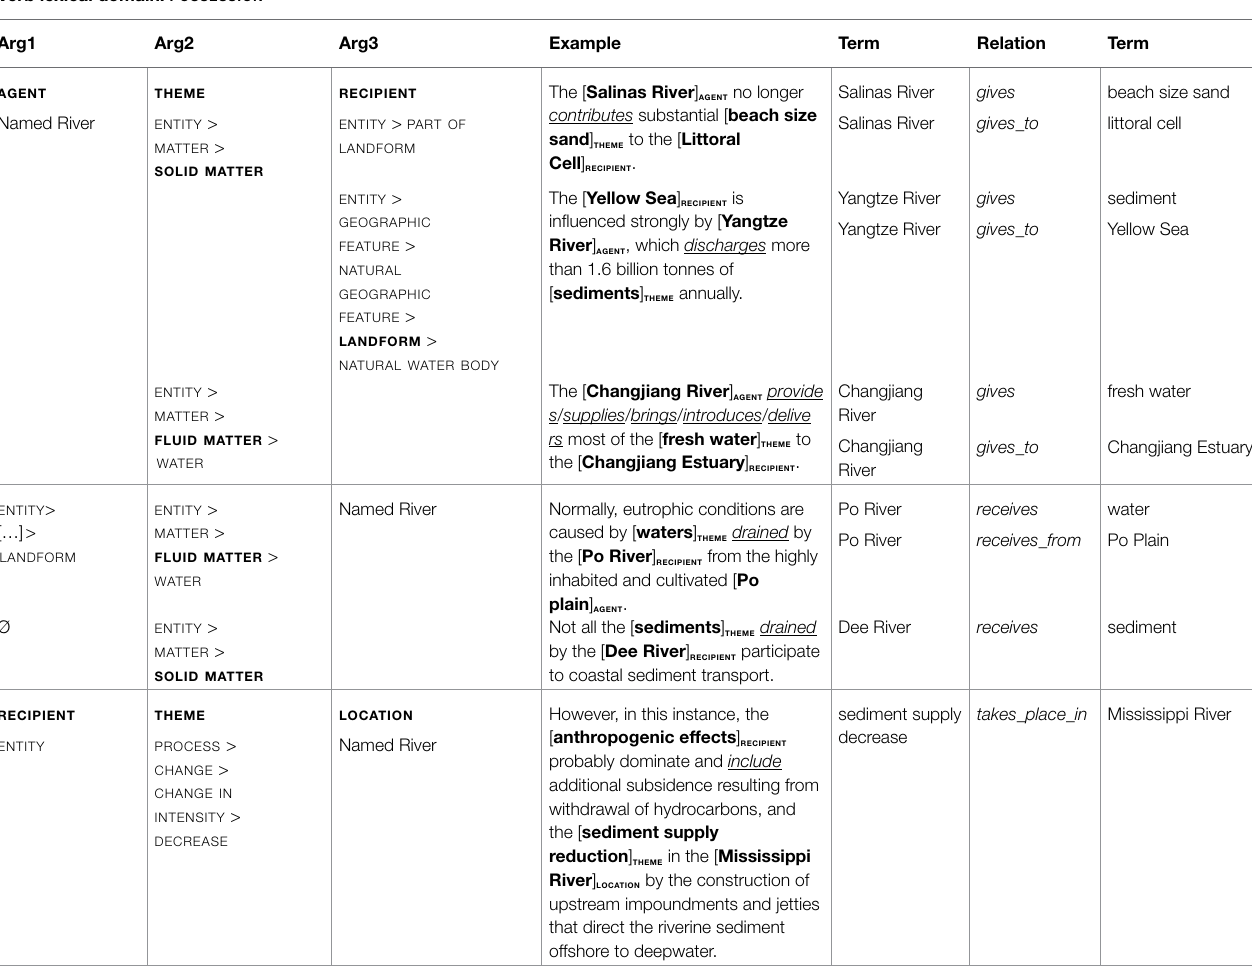
TABLE 5 | Results from the semantic annotations for the lexical domain of possession